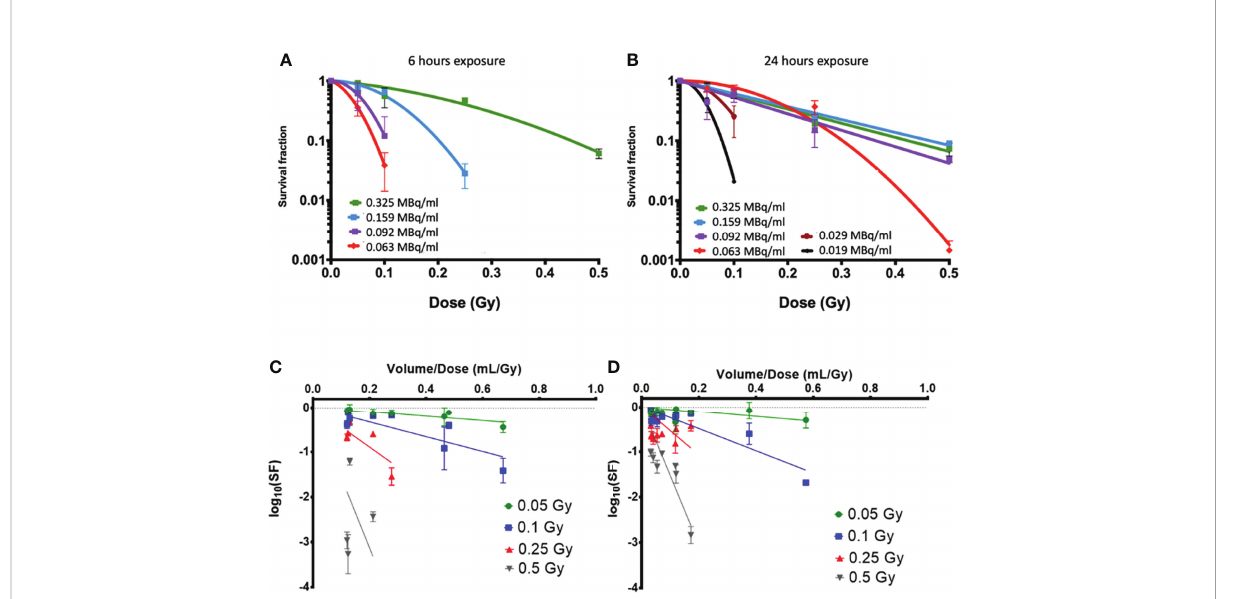
FIGURE 4 Clonogenic survival data on PC-3 cells exposed to 223 Ra for (A) 6 h and (B) 24 h using vials with different activities per milliliter at the time of the experiment [denoted in legend in (A, B) ]. While all cells were treated with the same activity for a given dose and time, different volumes of 223 Ra stock solution were needed to achieve a given dose, showing clear differences in survival. Here, the SFs are displayed as logarithm values. This can also be seen as a function of added volume when cells were exposed to alpha-particle doses of 0.05, 0.1, 0.25, and 0.5 Gy from 223 Ra exposures for (C) 6 h and (D) 24